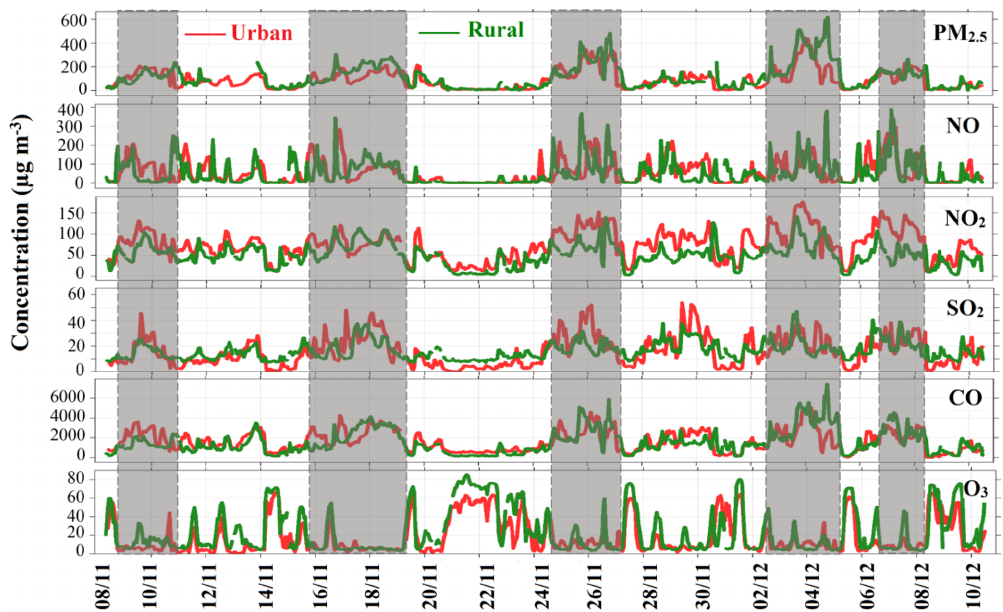
Figure 5. Time series of air quality variables at the urban and rural sites during the winter campaign. Five haze events are indicated (shading; see also Table 4). Table 4. Average air quality variables at IAP, Pinggu and 12 national monitoring sites (12N) during the field campaigns (10 November– 11 December 2016; and 21 May–22 June 2017). The 12 national sites 5-year mean concentrations for same times of the years (12N-5Y) and for the same time of the year (campaign period) (12N-campaign) are shown. Data are mean ± SD (range of daily mean